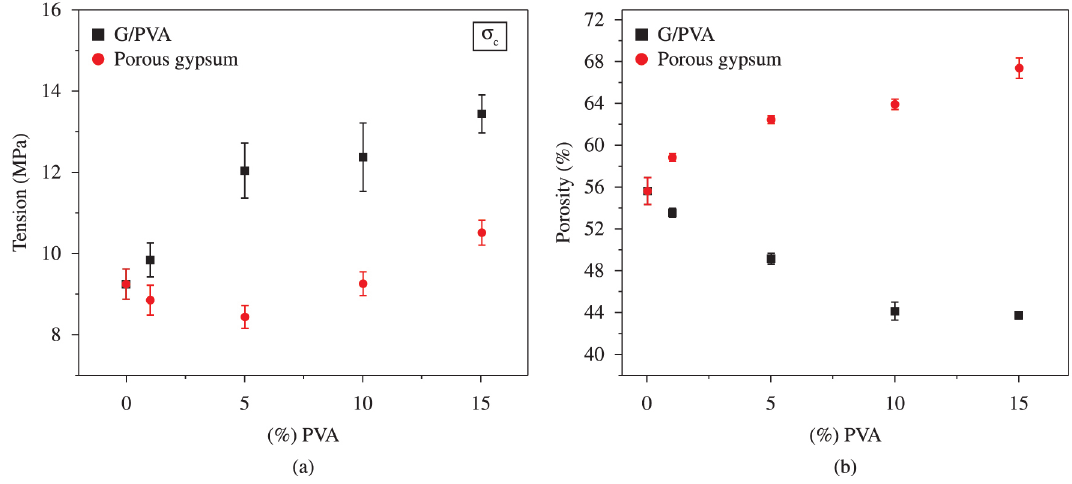
Figure 3. a)Resistance to compression and b)Geometric porosity, corresponding to different percentages of polymer weight, as well as to the composite before and after the removal of PVA in water.